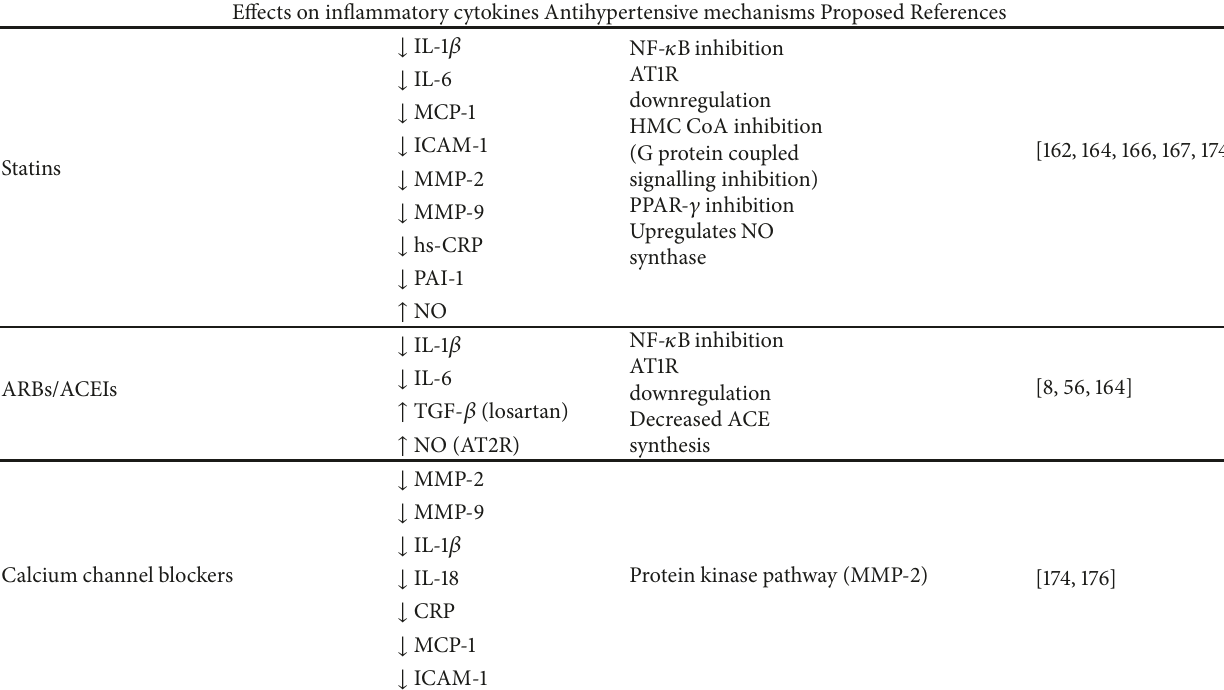
Table 2: Anti-inflammatory effects of cardiovascular